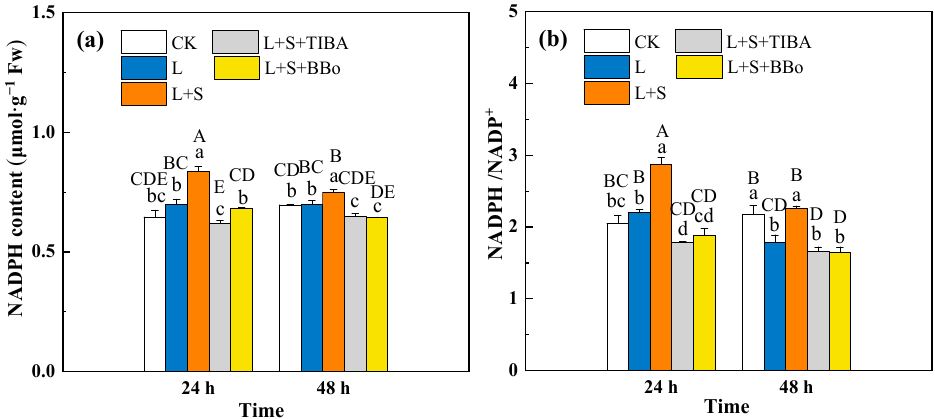
Figure 8. Effects of exogenous sucrose and IAA inhibitors on G6PDH activity of M. baccata under sub-low temperature. Bars indicate means ± standard error ( n = 3). The lowercase letters represent significant differences between treatments ( p < 0.05). The capital letters represent significant differ- ences between full data ( p < 0.05). The comparison of means is based on the Duncan’s multiple range test. CK, control treatment; L, sub-low root-zone temperature (5 ◦ C); L + S, 5 ◦ C + 90 mmol · L − 1 su- crose; L + S + TIBA, 5 ◦ C + 90 mmol · L − 1 sucrose + 500 µ mol · L − 1 2,3,5-triiodobenzoic acid; L + S + BBo, 5 ◦ C + 90 mmol · L − 1 sucrose + 300 µ mol · L − 1 4-biphenylboronic acid. (See Supplementary Materials).